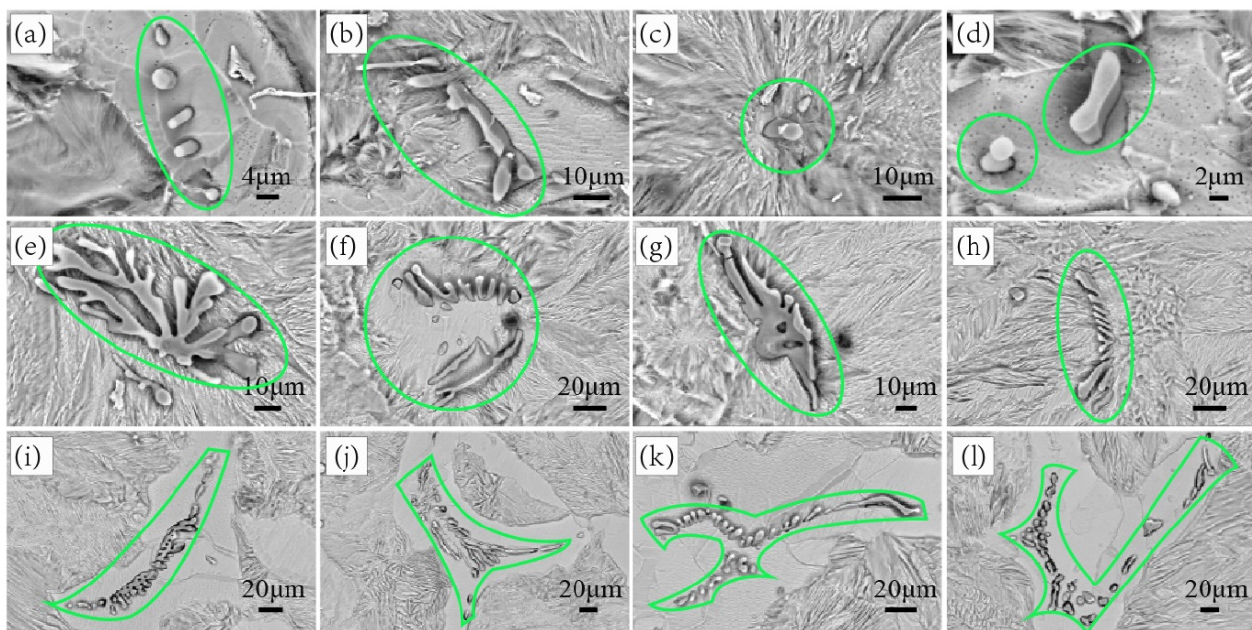
Figure 11. 3D morphology of MnS inclusions in as-cast sample. ( a – d ) Sample S2 of Steel A; ( e – h ) Sample S2 of Steel B; ( i – l ) Sample S2 of Steel C.